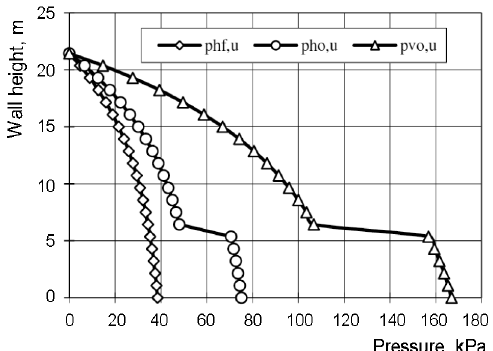
Fig. 6. Horizontal pressures during charging ( p hf , u ), discharging ( p ho , u ), and vertical pressure ( p vo , u ) in silo with effect of relief beams taken into account 5. Properties of pelleted material removed from silo after